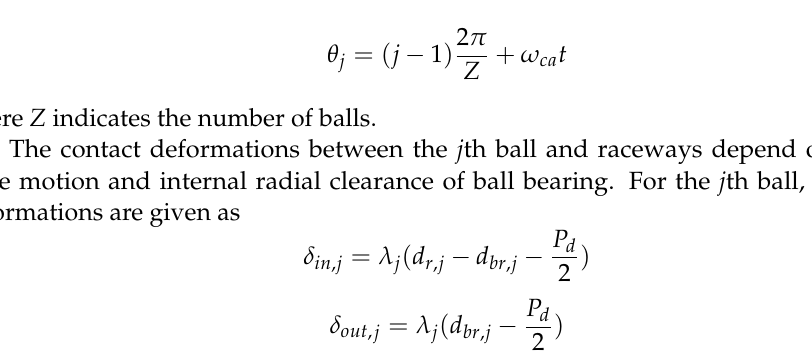
The angular position θ j of the j th ball is defined as